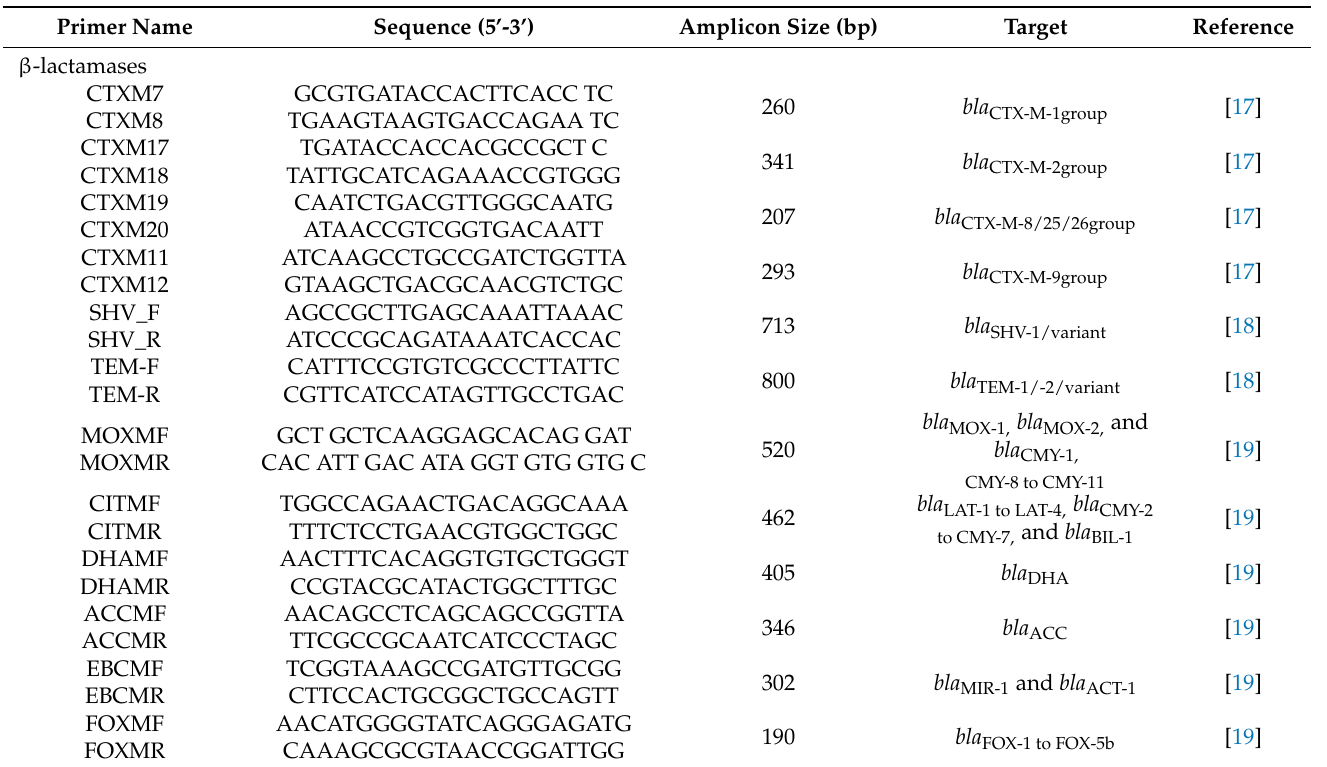
Table 1. Oligonucleotides used in this